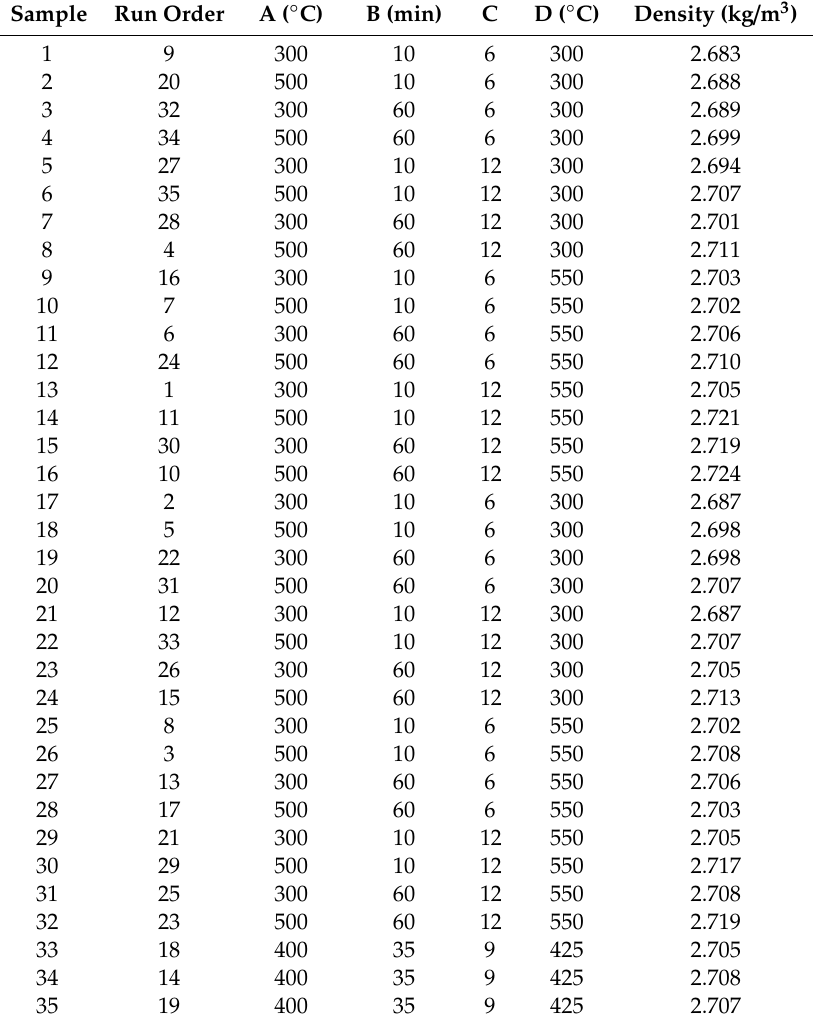
Table 2. Experimental design and the